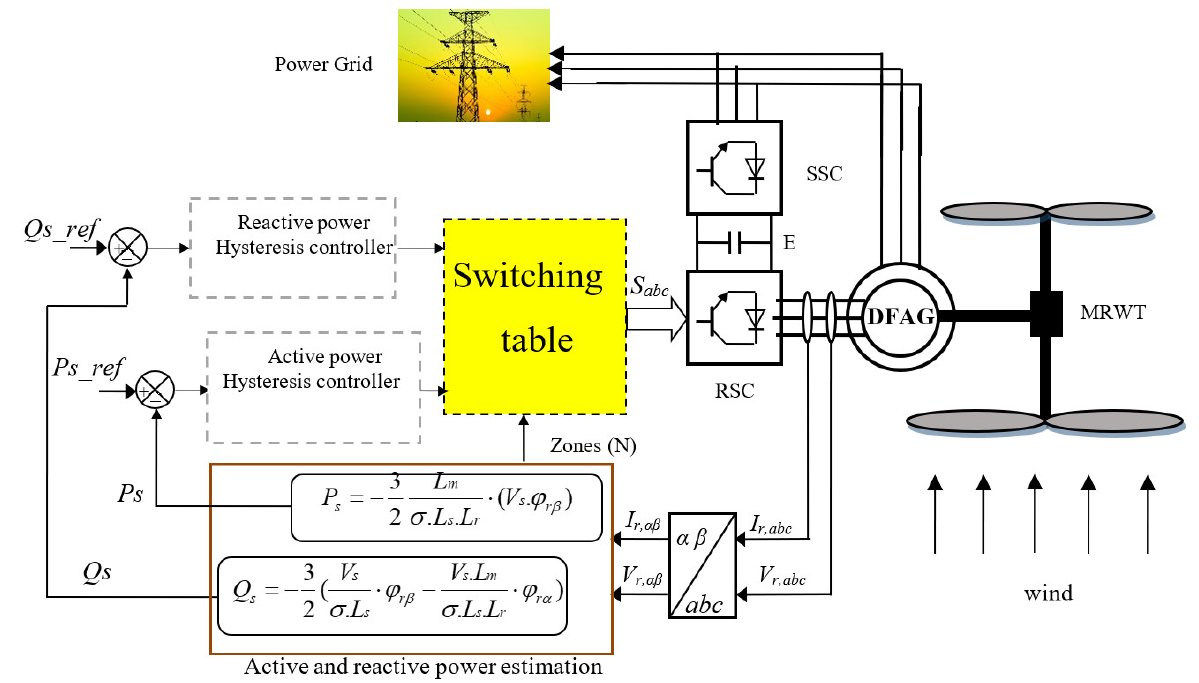
Figure 3. Classical DPC of the DFAG-MWRT system.